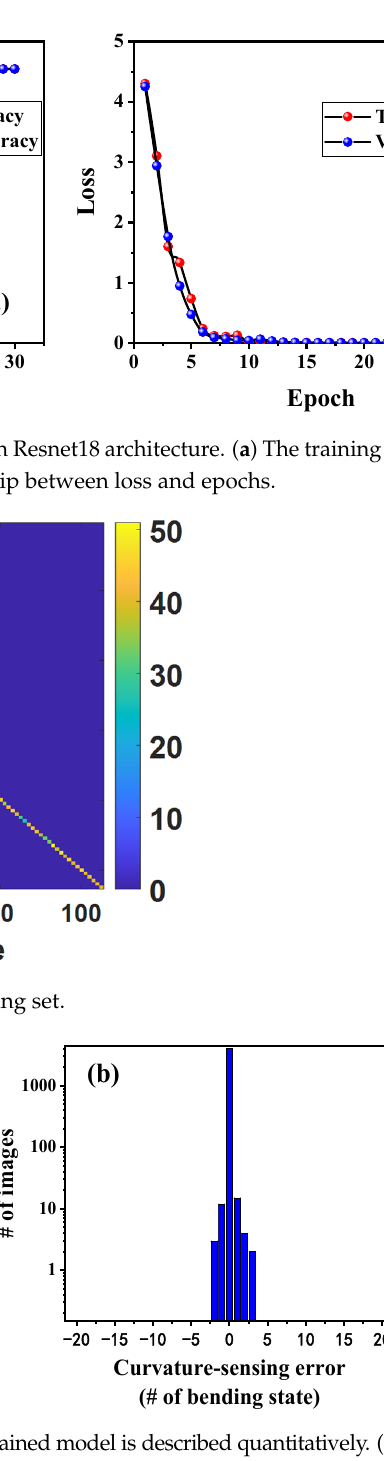
Figure 8. The generalization ability of the trained model is described quantitatively. ( a ) The histogram of the absolute position classification error. ( b ) The histogram of the absolute curvature classification error.